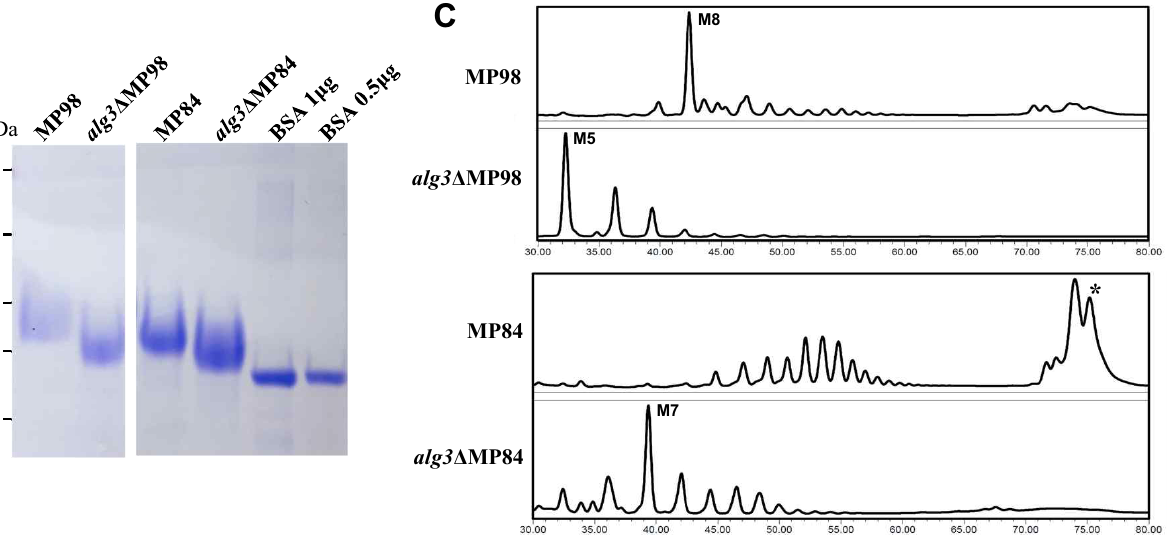
Figure 1. Secretory expression of MP98 and MP84 in C. neoformans WT and alg3 Δ mutant strains. ( A ) Scheme of His-tagged MP98 and MP84 without GPI anchorage. Details about the ORF, promoter, and terminator sequences of the genes encoding MP98 and MP84 were obtained from Broad Institute (https:// www. broad insti tute. org). Pfam and SMART were used for domain prediction. Signal sequence and GPI anchor sites were predicted using SignalP 4.1 Server and PredGPI. N- and O- linked glycosylation sites were predicted on the basis of NetNGlyc 1.0 Server, NetOGlyc 4.0 Server, and YinOYang 1.2 tool analysis. The native MP84 promoter was exchanged with the histone 3 (H3) promoter ( P H3 ) to direct a high MP84 expression. ( B ) Coomassie Blue staining of the purified MPs from C. neoformans WT and alg3 Δ strains. MPs were purified from cell culture supernatants and analyzed through SDS-PAGE with bovine serum albumin (1 μg BSA) for comparison. The raw data of Coomassie Blue staining in ( B ) was presented in Supplementary Information as Fig. S5. ( C ) HPLC profiles of neutral and acidic (*) N -glycans assembled on MP98 and MP84. M8, M5, and M7 represent Man 8 GlcNAc 2 , Man 5 GlcNAc 2 , and Man 7 GlcNAc 2 ,